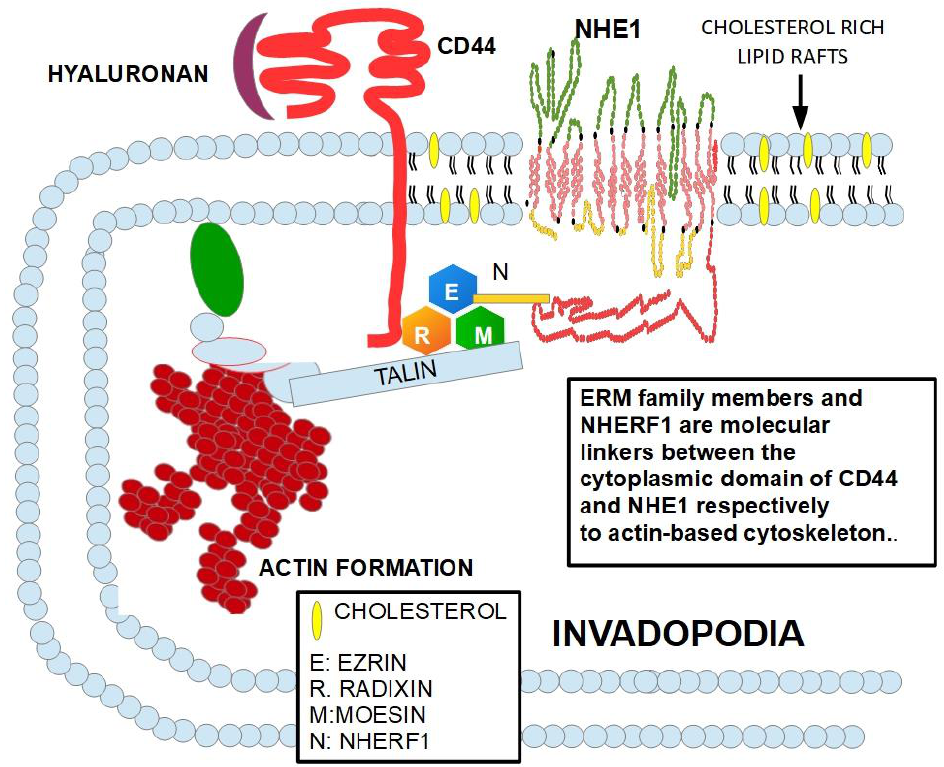
Figure 6. CD44 interacts with the ERM family which connects CD44 to the actin synthesis at the invadopodia. The diagram is based on references [115 – 121].